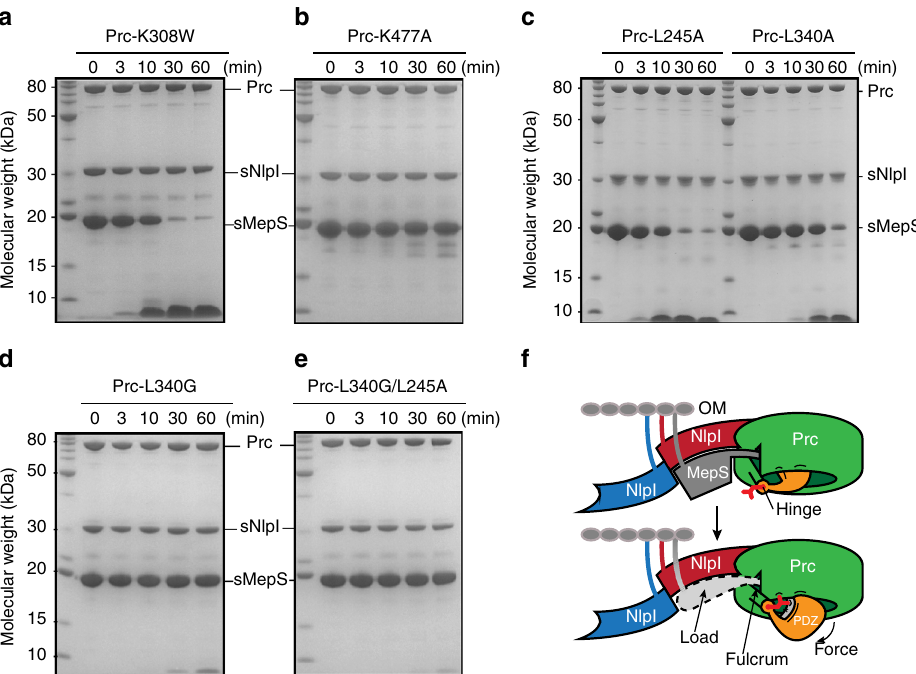
Fig. 9 Role of the hinge residues of Prc in NlpI-mediated substrate degradation. a – e SDS-PAGE assays monitoring sNlpI-mediated sMepS degradation by Prc-K308W a , the catalytically inactive Prc-K477A as a reference b , Prc-L245A c , Prc-L340A c , Prc-L340G d , and Prc-L340G/L245A e . f A lever-like working model for degradation of protein substrate containing a fl exible C-terminal tail by the Prc-NlpI complex. The initial cycle of substrate-docking (top) and ligand-triggered PDZ movement (bottom) steps are shown. See Discussion for details. The substrate C terminus is indicated by an asterisk. The ligand- sensing hydrophobic residues at the hinge are represented by a bifurcated side chain colored in red. The lipid anchors are depicted by colored curved lines linking to the outer membrane (OM). Sites for intramolecular interaction (e.g., the NHD and helix h9) and ligand binding in Prc are depicted by short black